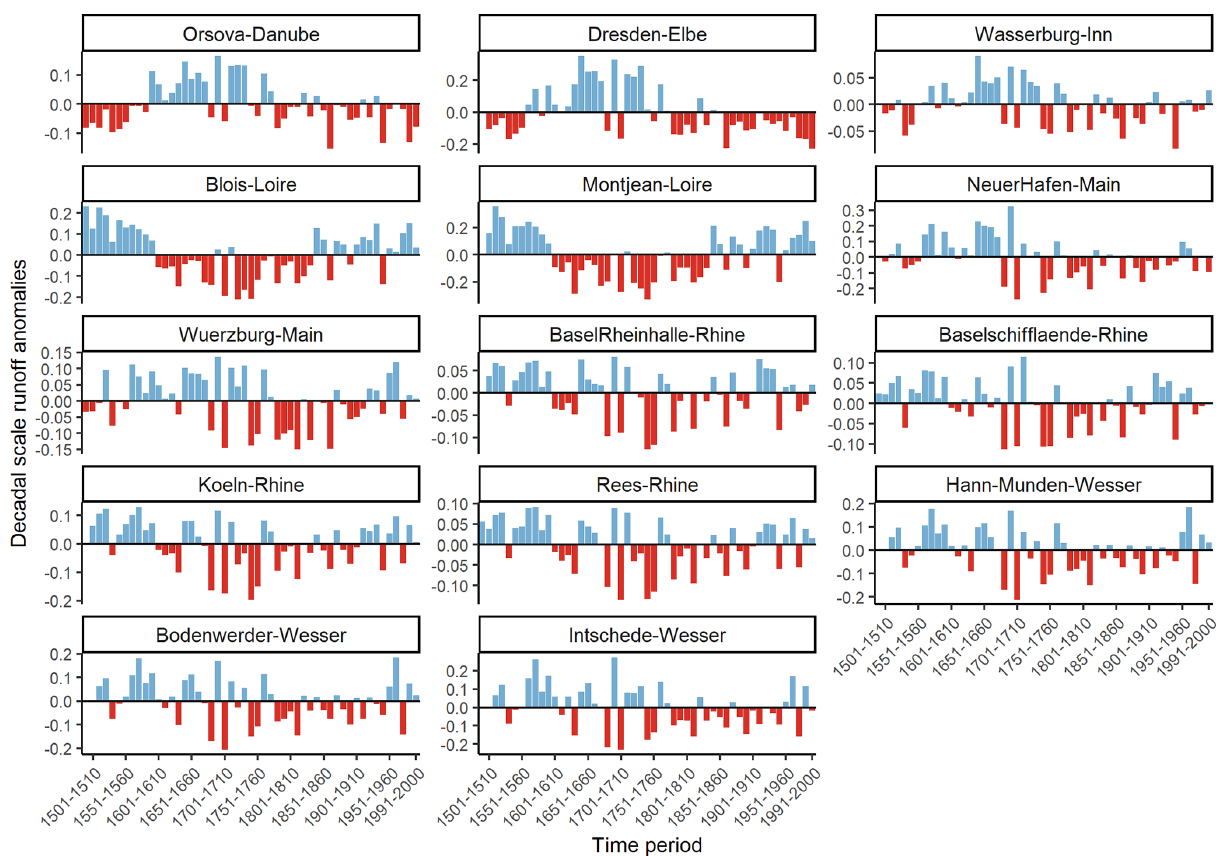
Figure A2. Decadal fluctuation of runoff anomalies in selected catchments over the past 500 years.